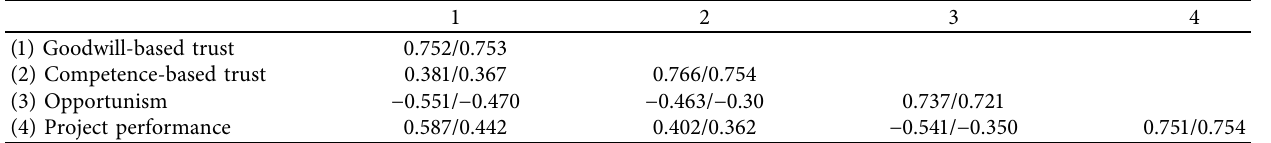
Table 5: AVE and correlation matrix.